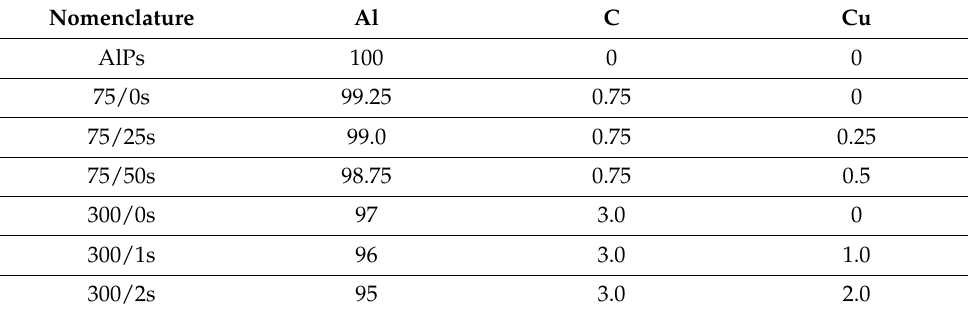
Table 1. Composition and sample identification (in wt.% and